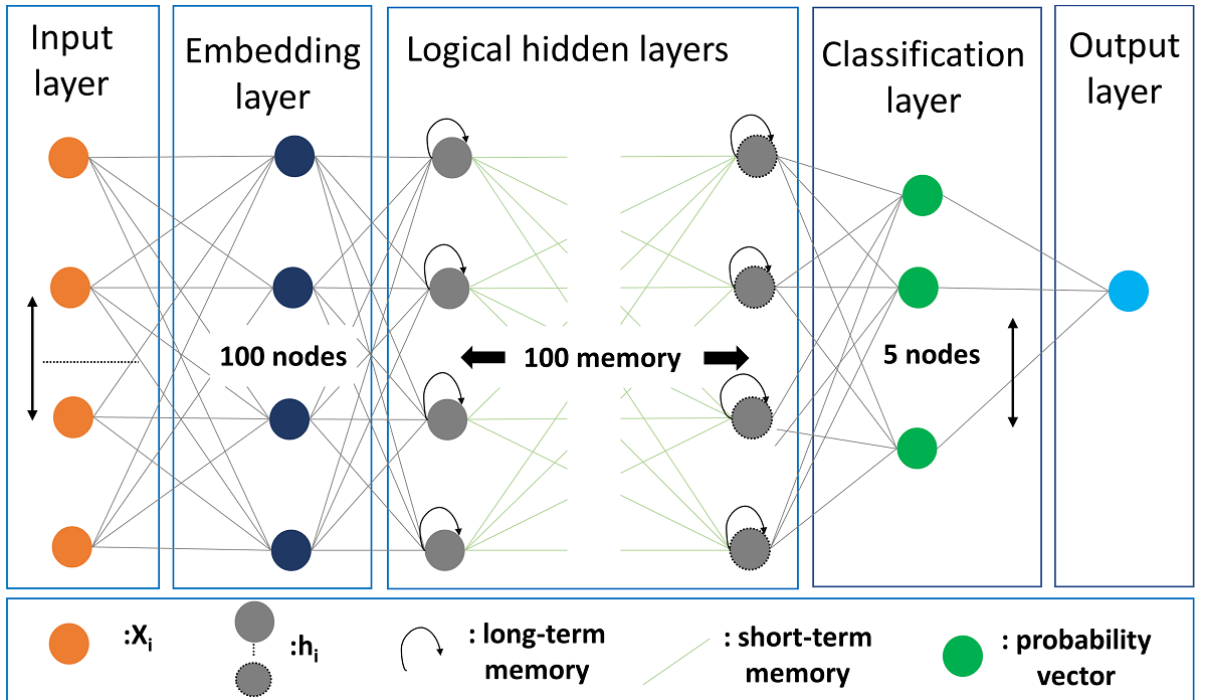
Figure 3. Clinical context–aware (CCA) classifier trained on 250-dimension feature vectors, 100 nodes at the embedding layer, 100 memory units of the long short-term memory (LSTM) layer logical hidden layers, and 5 classification